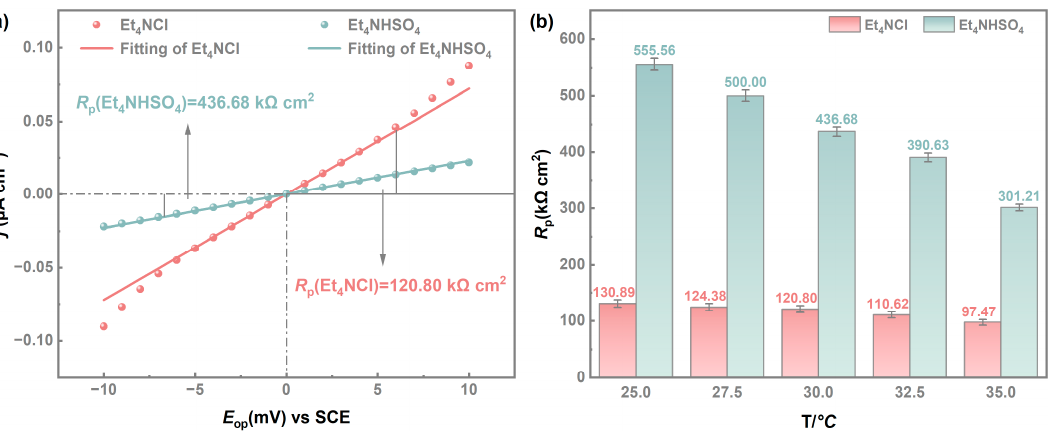
Figure 7. ( a ) Comparison of Hf corrosion in the Et 4 NCl and Et 4 NHSO 4 systems by polarization resistance analysis. ( b ) Polarization resistance kinetics of anodic Hf corrosion/dissolution in Et 4 NCl and Et 4 NHSO 4 based anhydrous ethanol systems. The polarization resistances were calculated based on the Stern–Geary equation. Condition: on Hf in the ethanol and acetonitrile ( V / V = 1:1) solution containing 0.06 M Et 4 NCl or Et 4 NHSO 4 at a scanning rate of 1 mV/s and different temperatures.